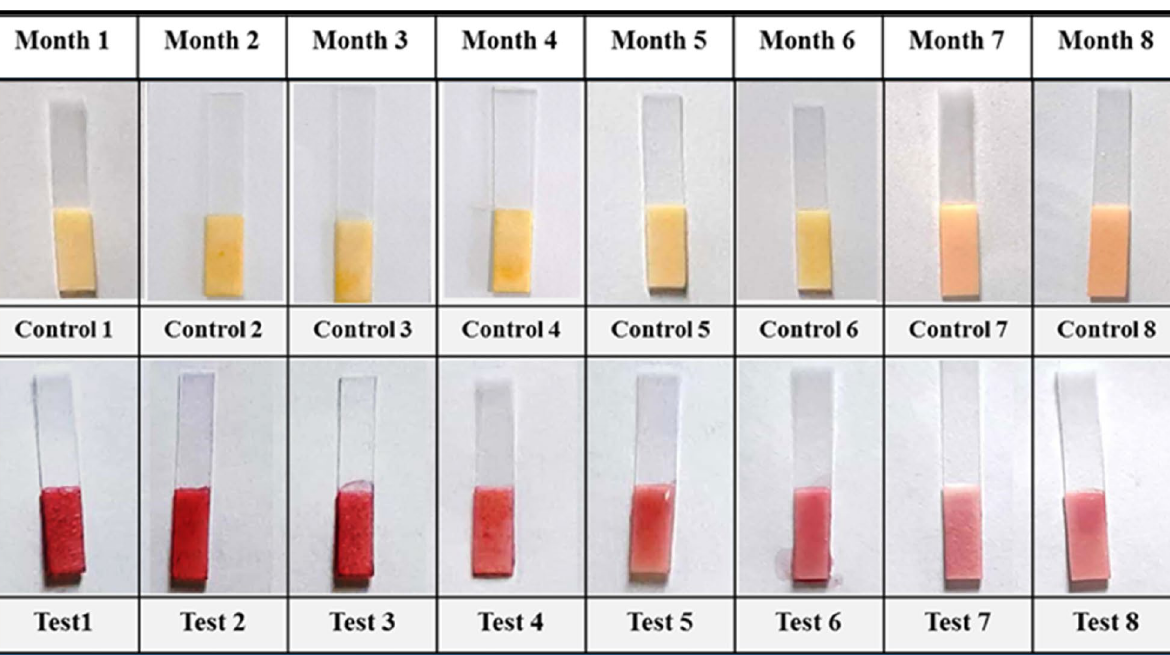
Figure 11. Shelf life stability of vacuum packed, substrate functionalized paper strip stored at − 4 °C, shows the best colour intensity up to 8 months of